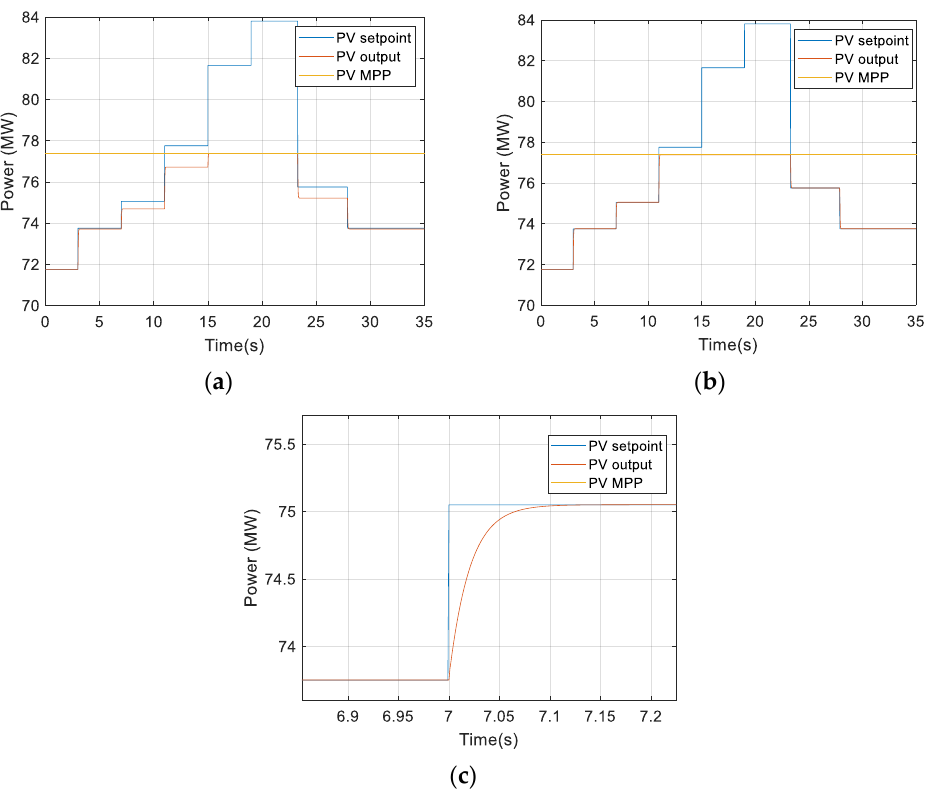
Figure 8. Plant control capability when the ( a ) reference was equally divided, and ( b ) reference was divided proportional to the reserve; ( c ) inverter control performance.